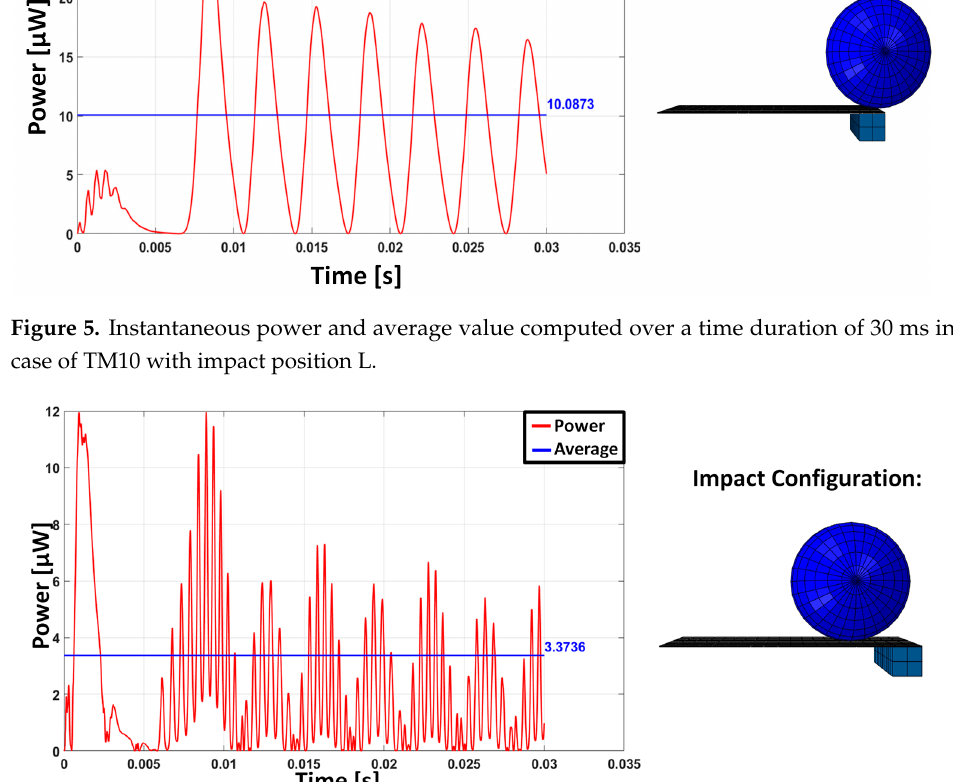
Figure 7. Instantaneous power, and average value computed over a time duration of 30 ms in the case of TM10 with impact position L/2. Having examined the effect of the impact position, the role of the size of the tip mass for the impact-based energy harvester is now presented. Figure 8 shows the responses in terms of the mean power (computed over a time duration of 30 ms) of all the cases. In the case of impact at the free edge, it can be noted that the power output increased at the decreasing tip mass, contrary to what occurs in the case of a linear resonant device. If the beam is forced with a harmonic input at a given acceleration, the presence of the mass is beneficial since it adds an inertial contribution that amplifies the oscillations. The same interpretation can be reached from a modal-dynamics point of view: by exciting the first mode of the structure, the mass attached to the tip increases the participating mass to the motion; therefore, energy is involved. This is not true in the case of impacts: the added mass creates resistance to the impacting body by introducing an inertial contribution due to the conservation of momentum. This causes a decrease in deformation and, so, involves electric power. The impact at ¾ L always shows a lower power generation compared to the other cases due to the fact that the impact point is very close to the node of the second bending mode of vibration and, most importantly, since multiple impacts happen before the sphere detaches the beam. The multiple impacts induce a strong limitation of the beam movement so that the power production is small. The impact at the midpoint of the beam length shows a non-monotonic power gen- eration again in view of the presence of multiple impacts: as far as the tip mass is low (or absent), the beam rebounds promptly, and the sphere is hit again. For intermediate tip masses (i.e., TM2-TM3-TM4-TM10), the second impact does not happen, and the power